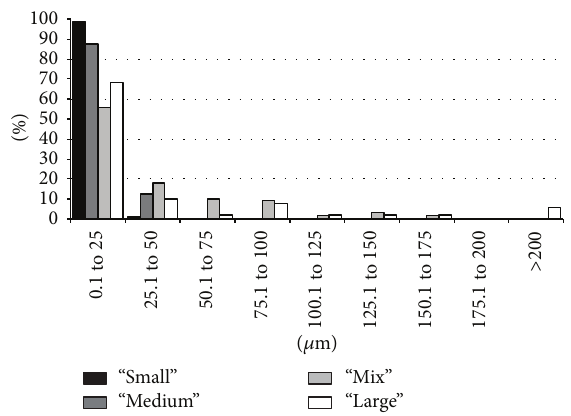
Figure 3: Pore sizes. Distribution of the pore sizes (in 𝜇 m) for each material (black, dark grey, light grey, and white for “Small,” “Medium,” “Mix,” and “Large,”